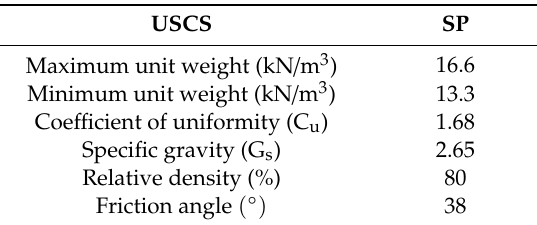
Figure 2. Jumunjin sand particle size distribution. Table 1. Properties of